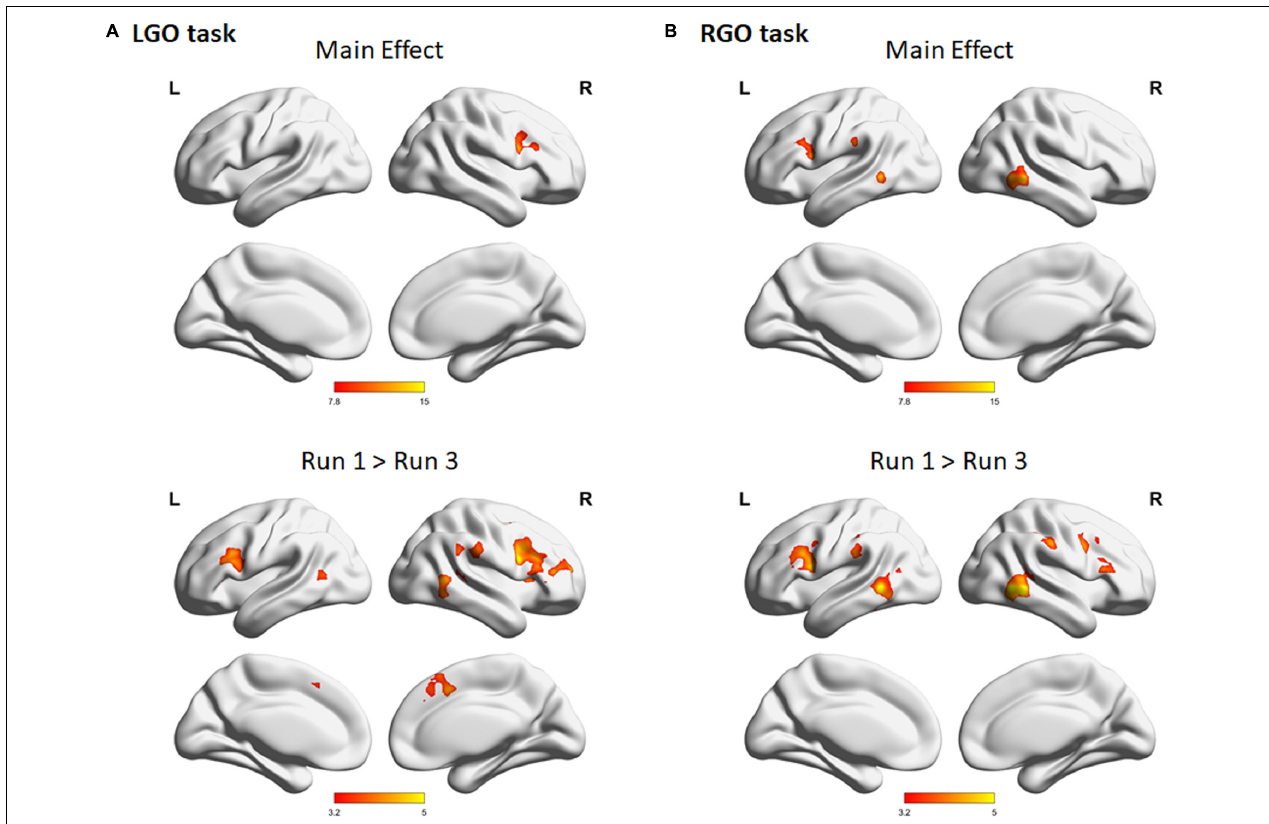
FIGURE 5 | Regions showing significant main effect in one-way repeated measures analysis of variance for the imagined (A) LGO and (B) RGO tasks. Results of post hoc paired sample t -tests for both LGO and RGO tasks are also shown in the bottom figures. All statistical maps were corrected for multiple comparisons using FWEc p < 0.05 with CDT p =